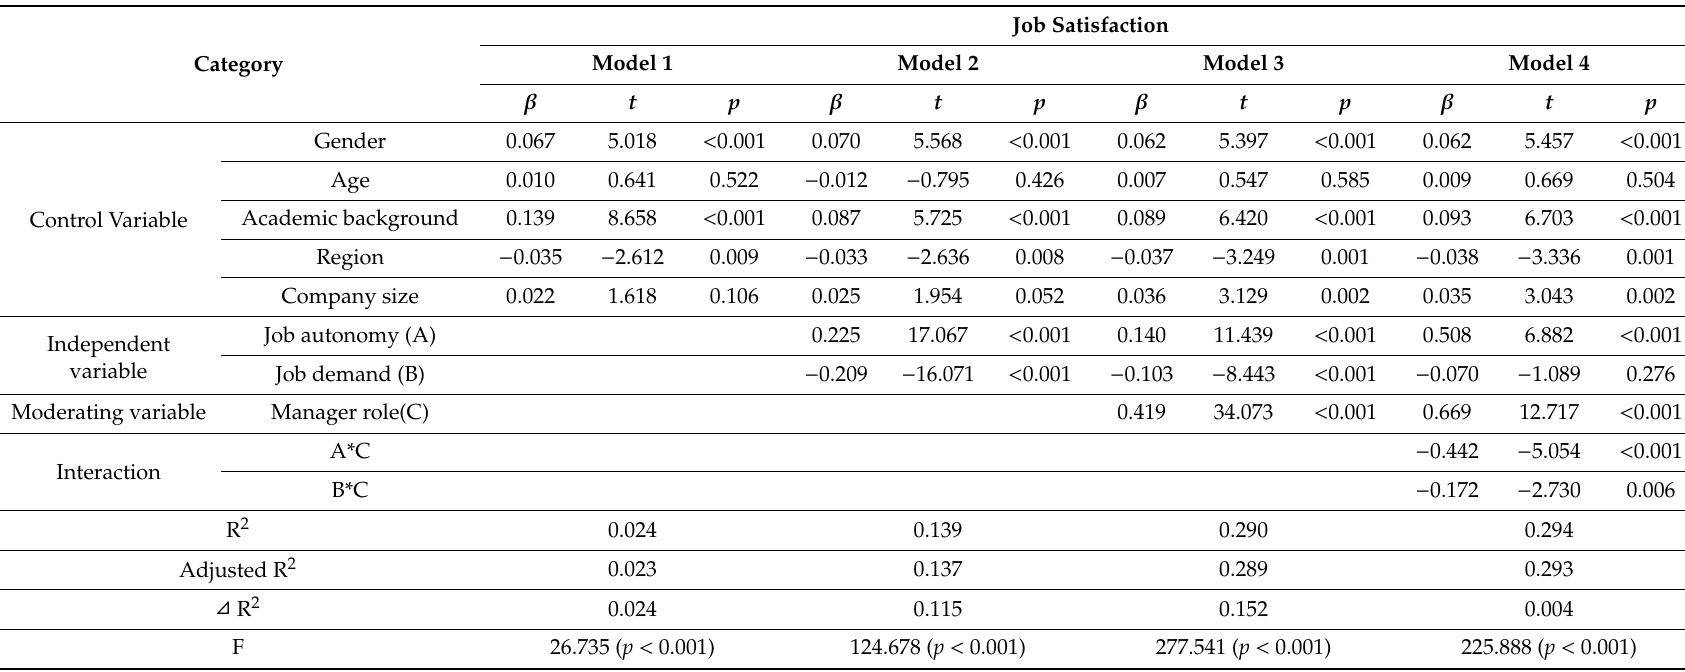
Table 6. The moderating e ff ect of managerial roles in the relationship between job stress and satisfaction in irregular employees.